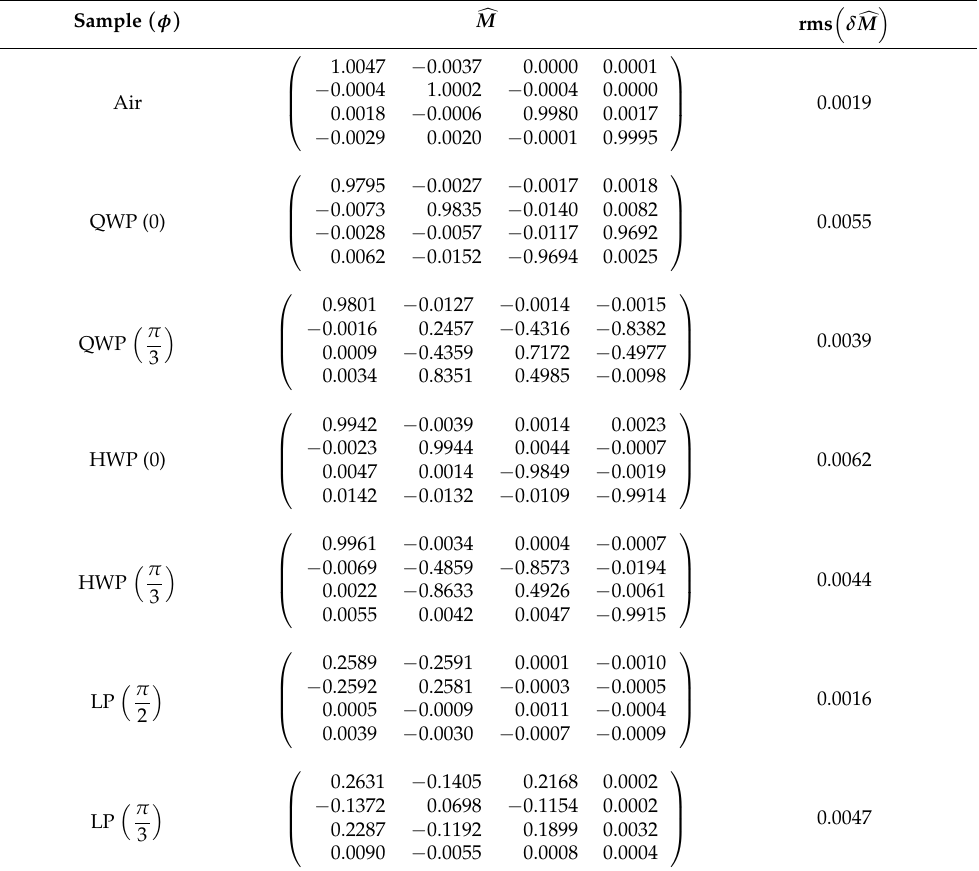
Table 2. Experimental Mueller matrices obtained for different samples (Air, QWP, HWP, LP) and orientations ( φ ). The last column reports the rms of the difference between the experimental Mueller matrices and the expected